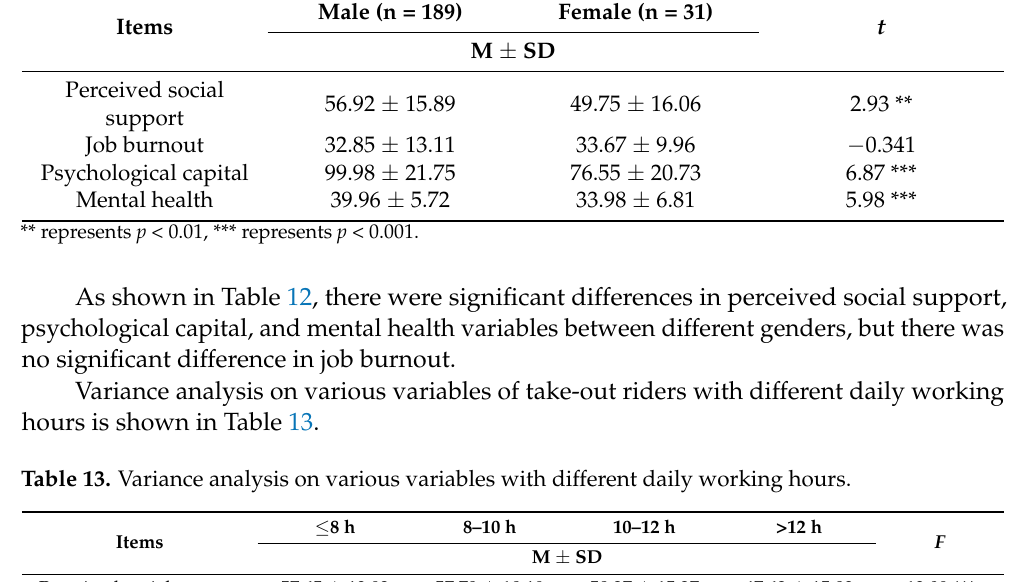
Table 12. The independent sample t -test results of different gender riders. Male (n = 189) Items Perceived social support